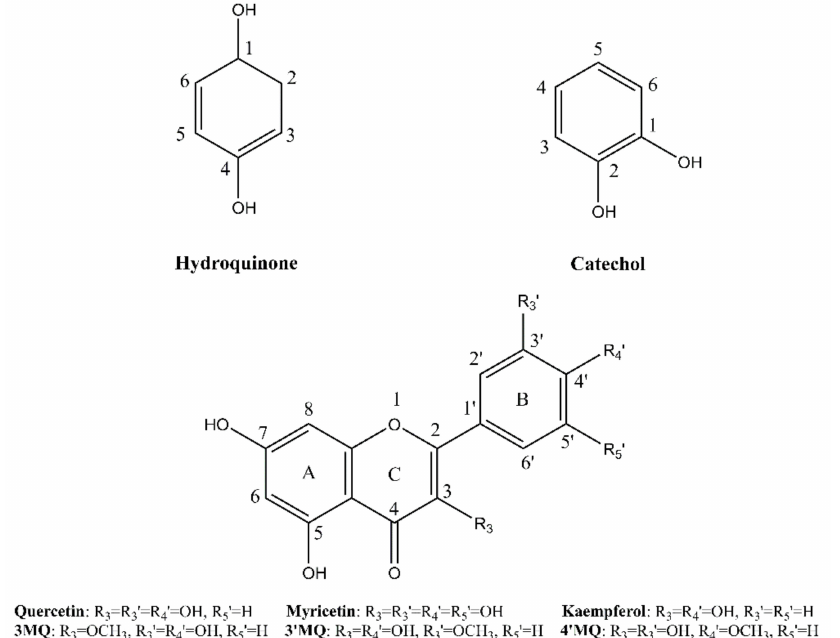
Figure 7. The structures of the tested